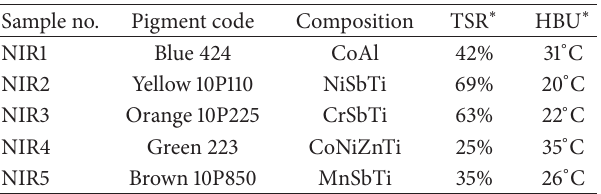
Table 2: Composition and important properties of NIR-reflective additive used in this study. Sample